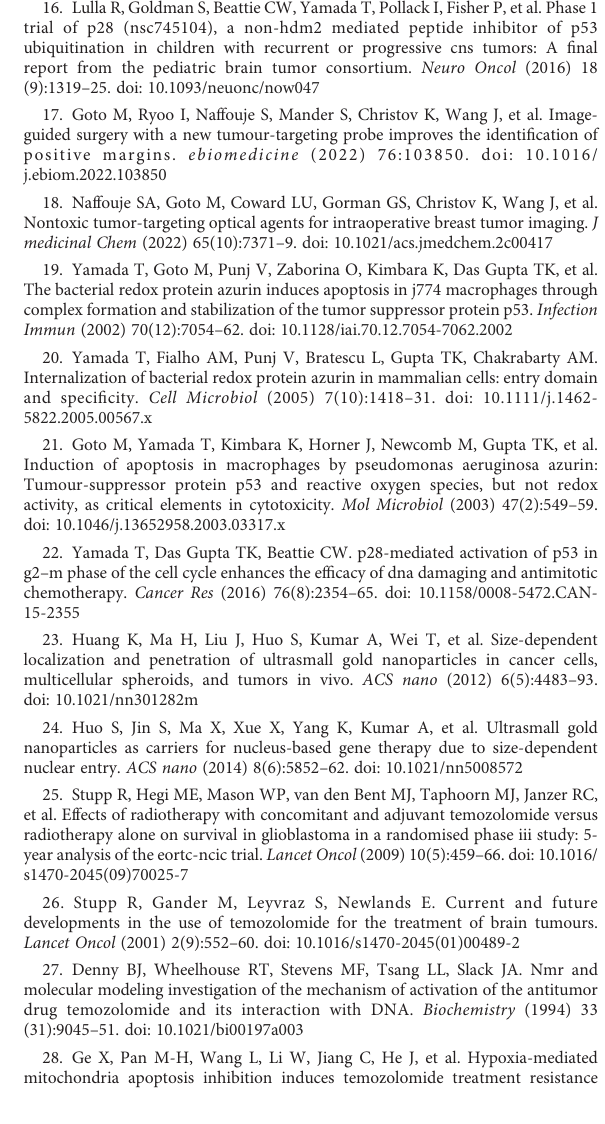
Supplementary Figure 1 TEM image of GBM cells exposed to GNRs alone. LN-229 cells were treated with GNRs alone for 2 hr. Sections (60 nm) of fi xedcellson200meshcoppergridswereimaged.TEMimagestakenbya JEOL 1220 showed very little GNP cellular